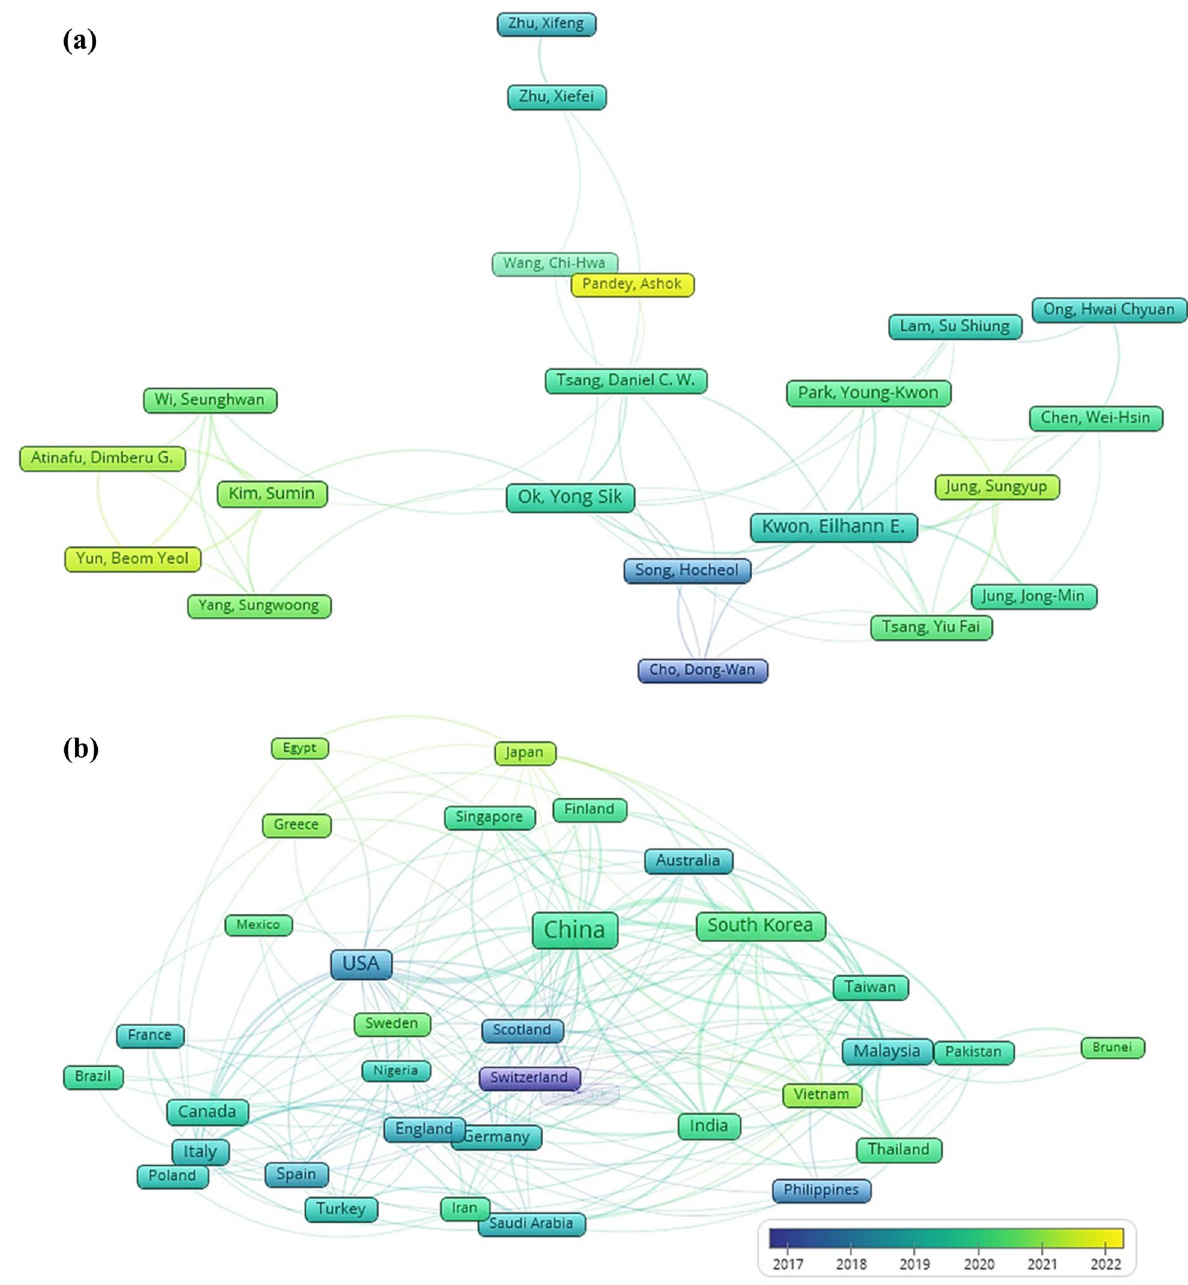
Fig. 5 Bibliometric network for energy production, conversion, and storage between a authors and b countries at minimum 5 document